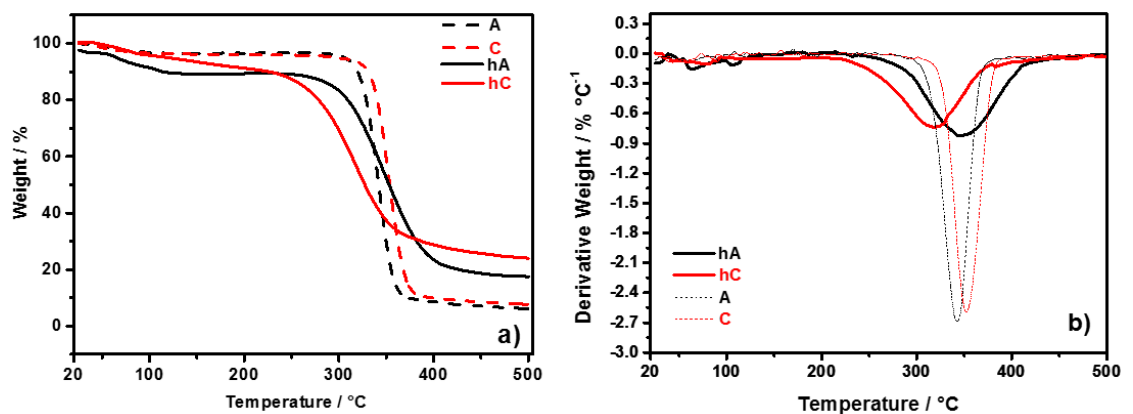
Figure 3. ( a ) TGA curves of C and A celluloses, and of their hydrogels (hC and hA, respectively); ( b ) First derivative of weight curves.